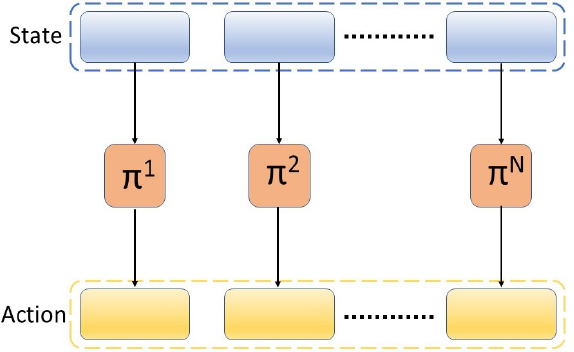
Figure 2. Multi-agent reinforcement learning framework.